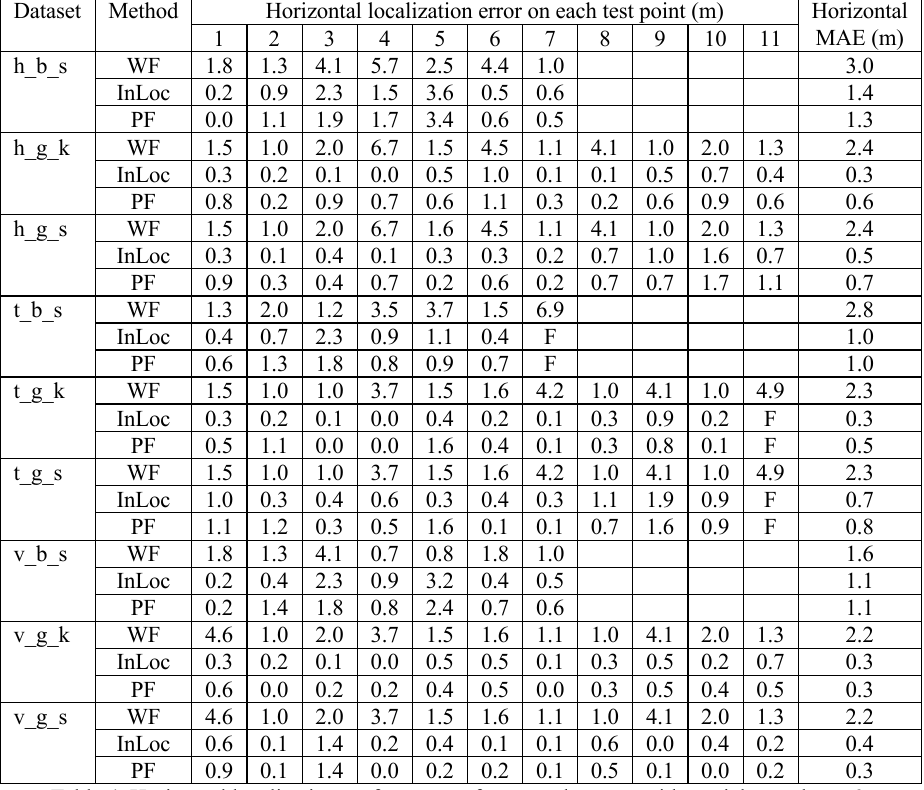
Table 4. Horizontal localization performance of proposed system with particle number = 3.